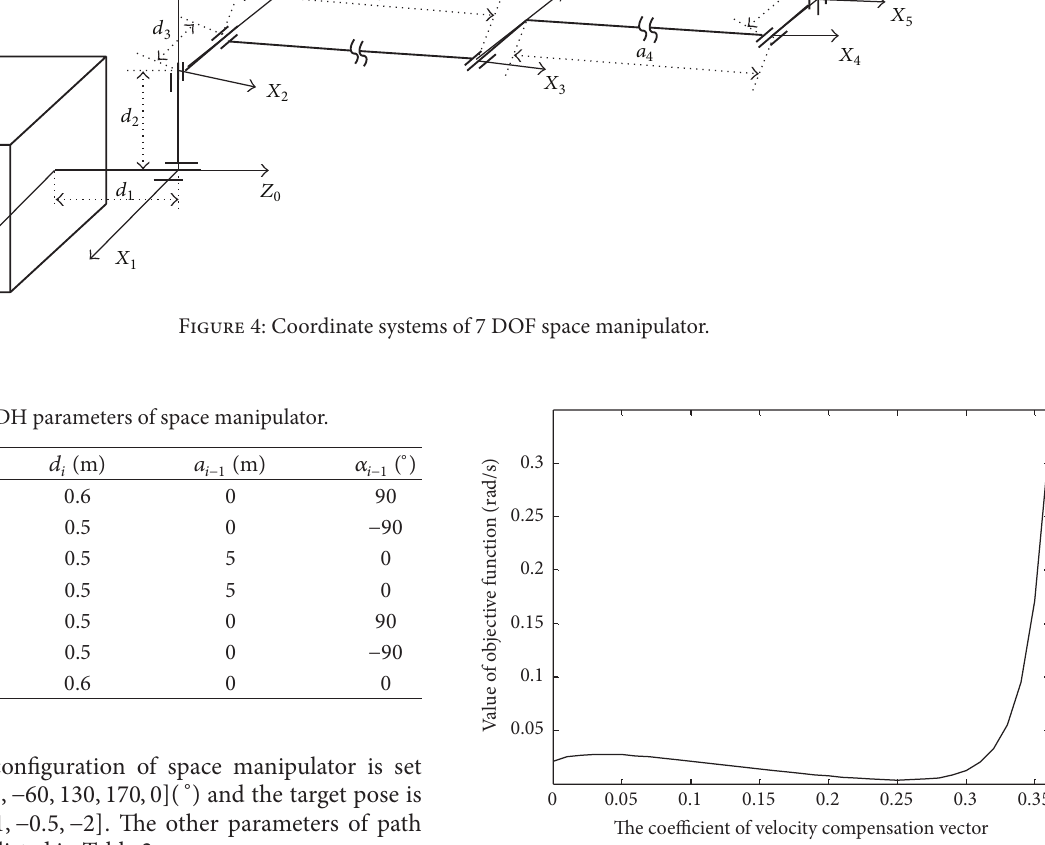
Figure 5: Value of objective function changes with 𝑐 𝑘